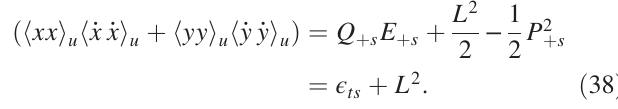
ffiffiffiffiffiffiffiffiffiffiffiffiffiffiffi 1 þ